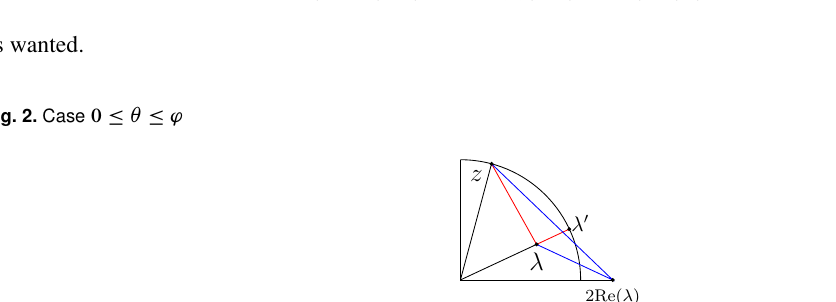
Fig. 2. Case 0 (cid:20) (cid:18) (cid:20)